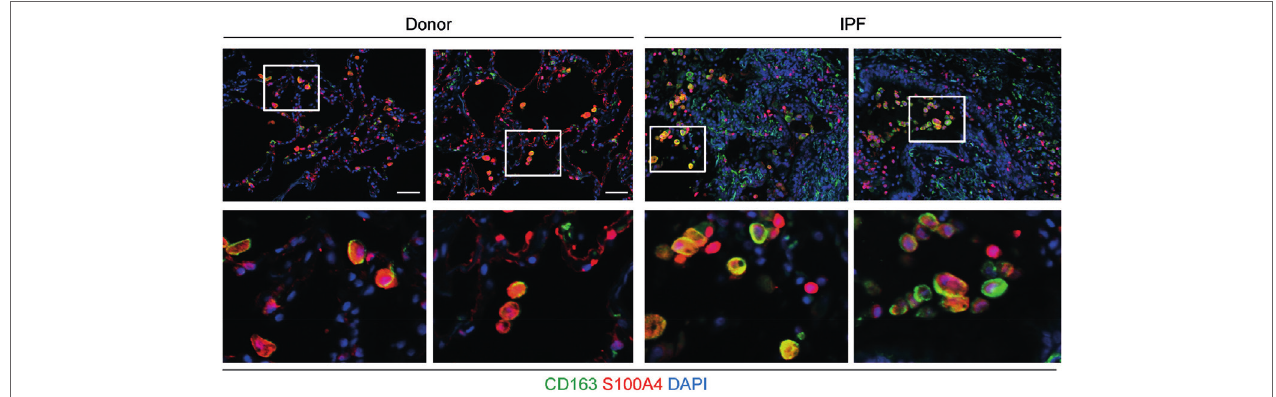
FigUre 3 | S100A4 is expressed by CD163 + macrophages in tissue sections from human lungs. Representative immunofluorescent stainings of paraffin sections from donor (left-hand panels) and idiopathic pulmonary fibrosis (IPF) tissue (right-hand panels) including higher magnification inserts in the bottom row. S100A4 is shown in red, the macrophage marker CD163 in green, and diamidino-2-phenylindole (DAPI) in blue. Scale bar 50